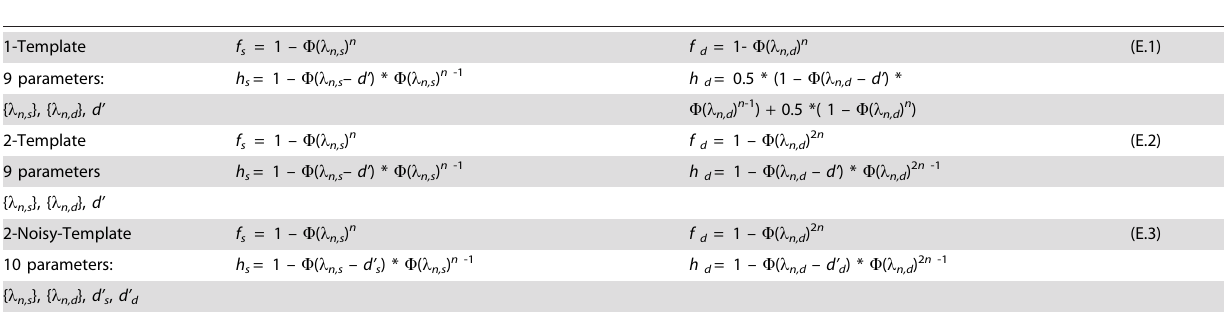
Table 1. Expressions for the 1-Template, 2-Template and 2-Noisy-Template models of single- and dual-target search.